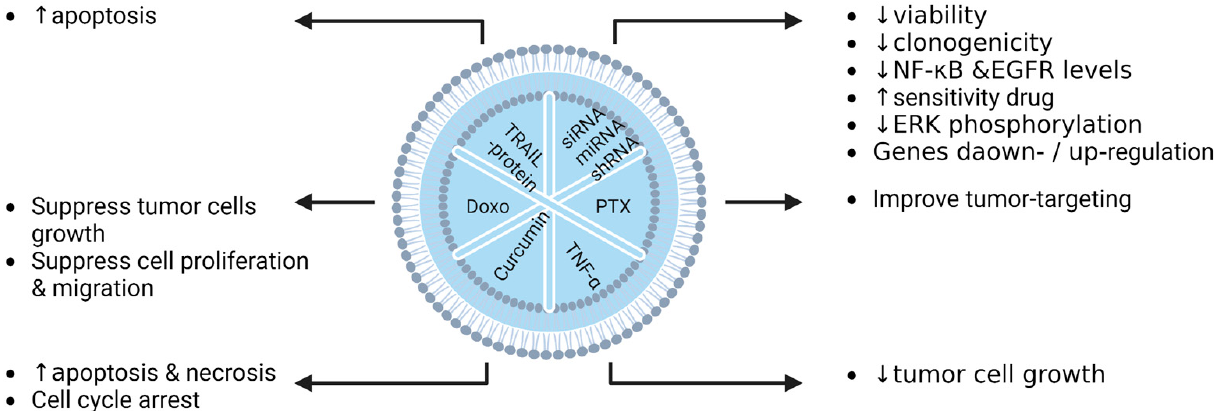
Figure 4. Summary of EV cargos, and their relevant effects on cancerous pathologies in vitro (Doxo: doxorubicin, PTX: paclitaxel, ↑ : increase, ↓ : decrease).